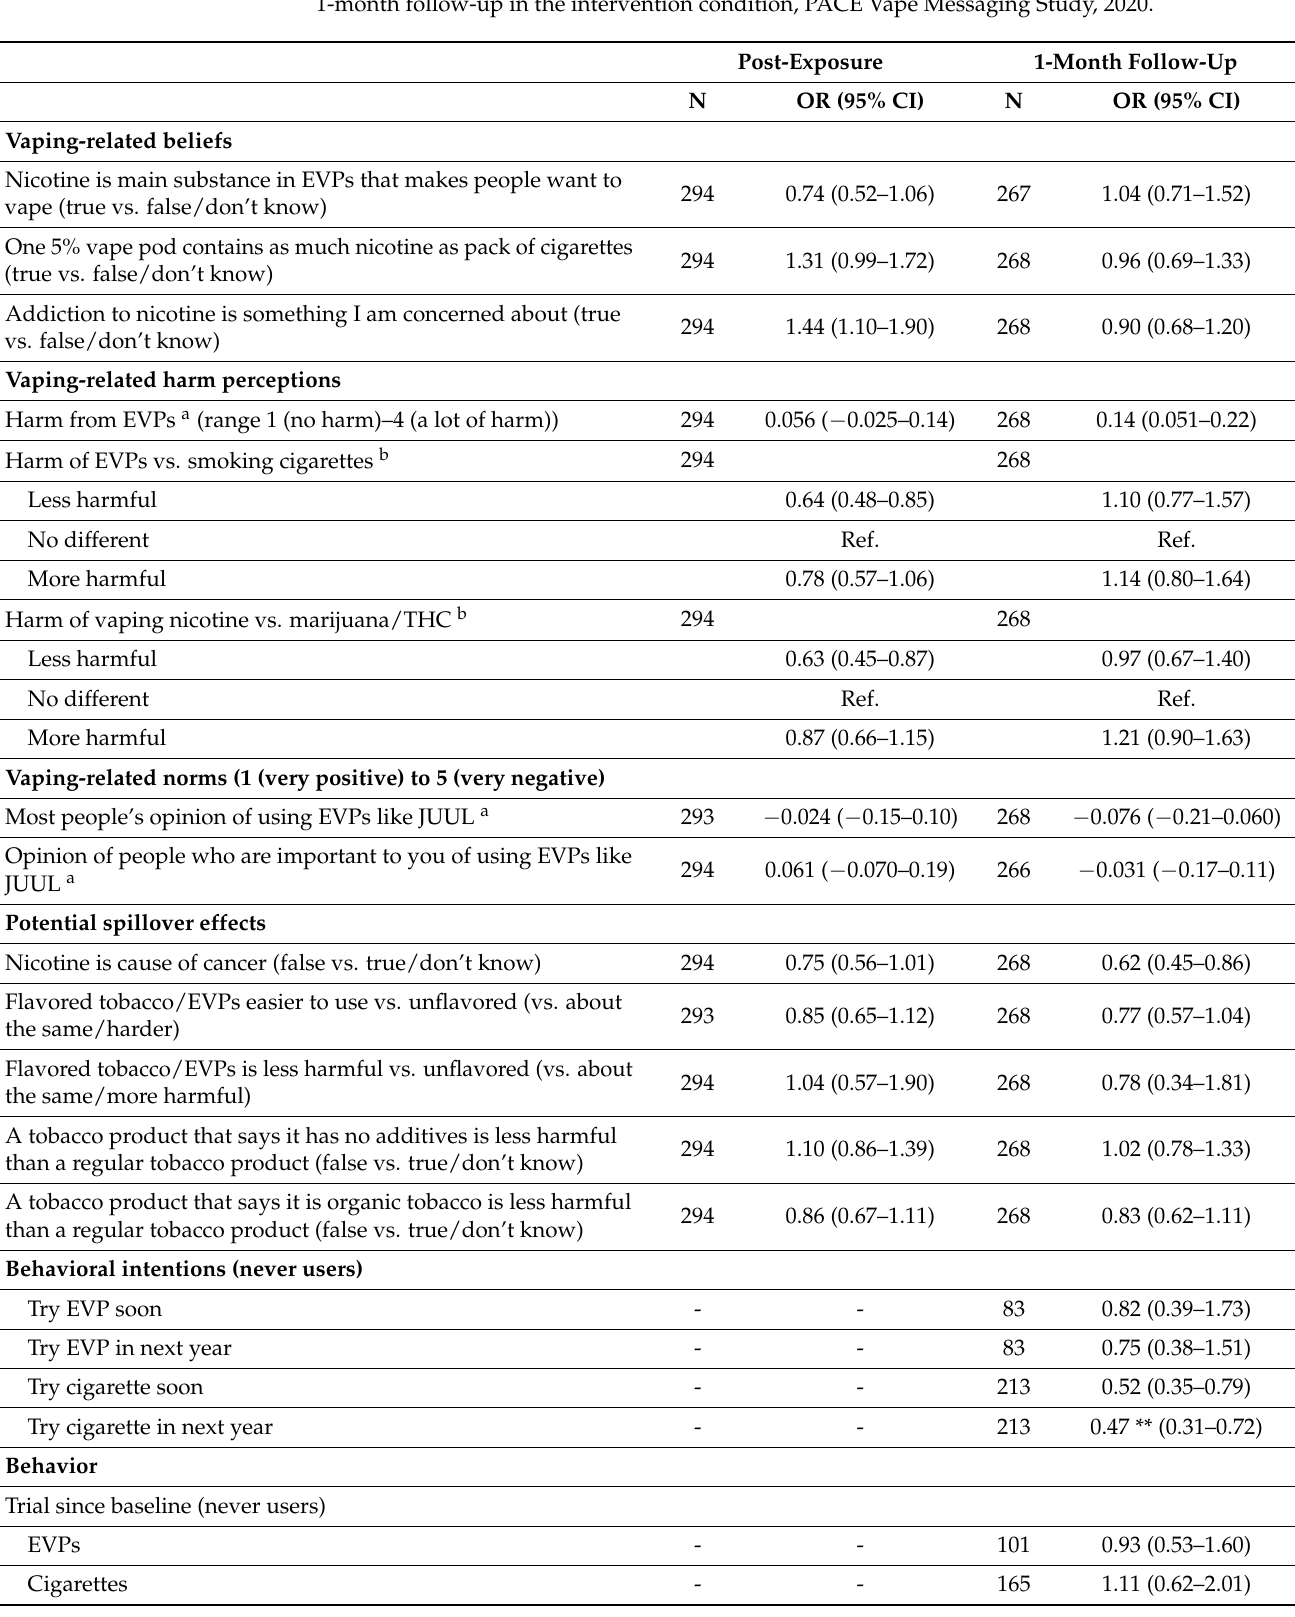
Table 5. Association between mean perceived message effectiveness (PME) and vaping-related beliefs, harm perceptions, norms, behavioral intentions, and behavior immediately post-exposure and/or at 1-month follow-up in the intervention condition, PACE Vape Messaging Study,